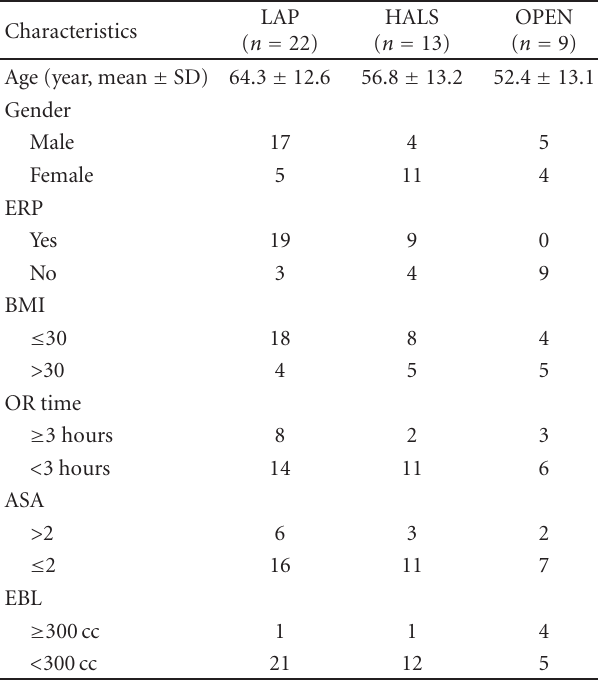
Table 1: Clinical data of colectomy patients.